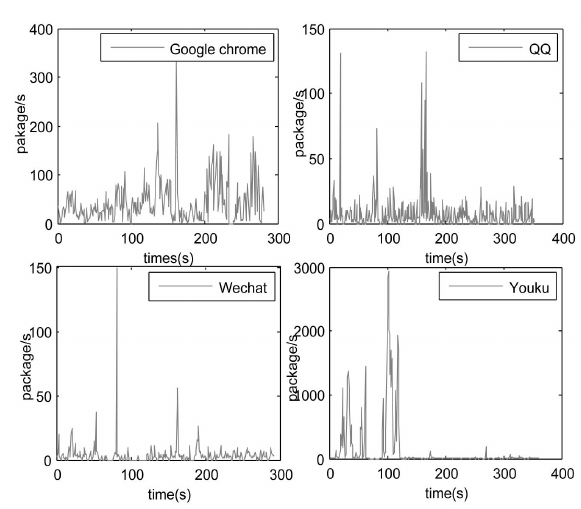
Fig. 3. (b) The jitter of Wi-Fi signal when the smartphone was far away from AP